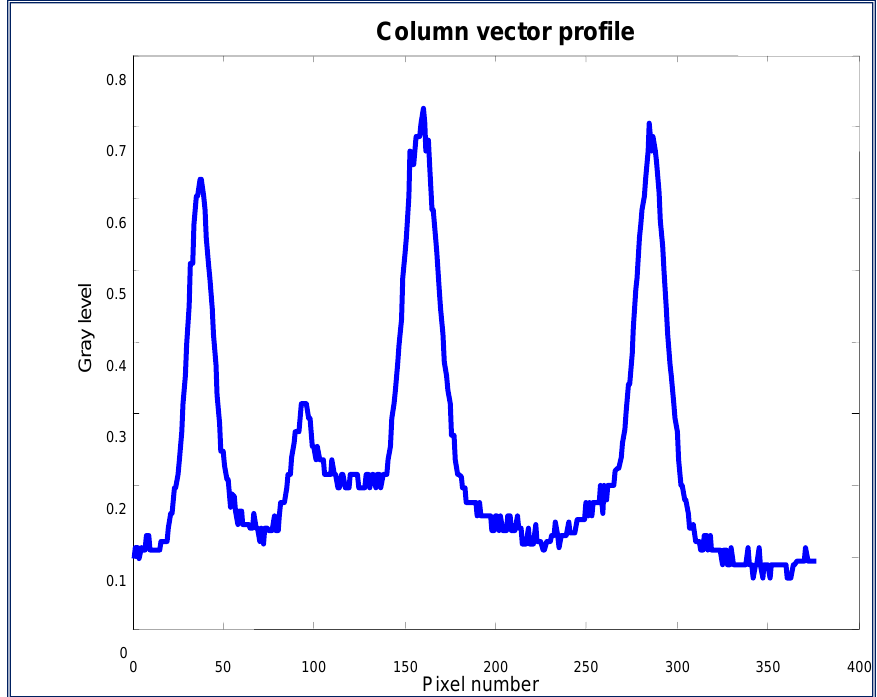
Figure 16. Column vector profile that contains the interest